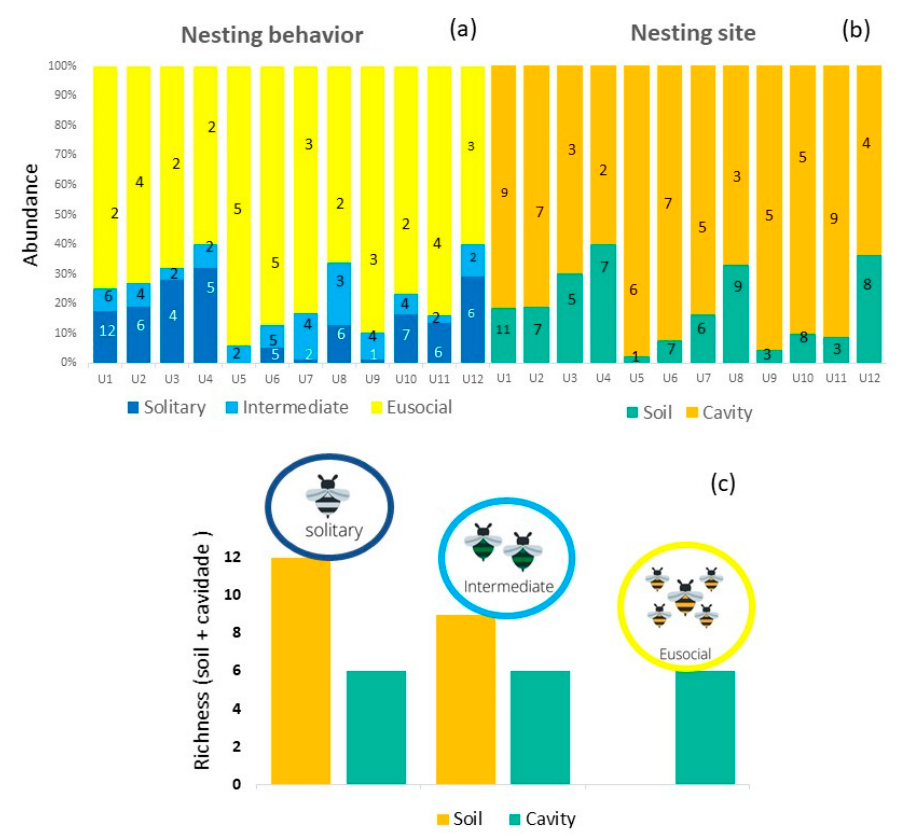
Figure 2. Relative abundance and richness (numbers inside bars) in each UGA: ( a ) nesting behavior, ( b ) nesting site, ( c ) species richness of soil- and cavity-nesting bees considering the different social groups.